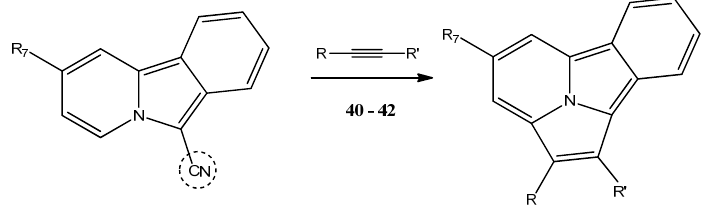
Table 9. Substituents, conditions and yields in cycloaddition of acetylene to 3-CN-substituted ben- zoindolizines giving benzocyclazines (Scheme